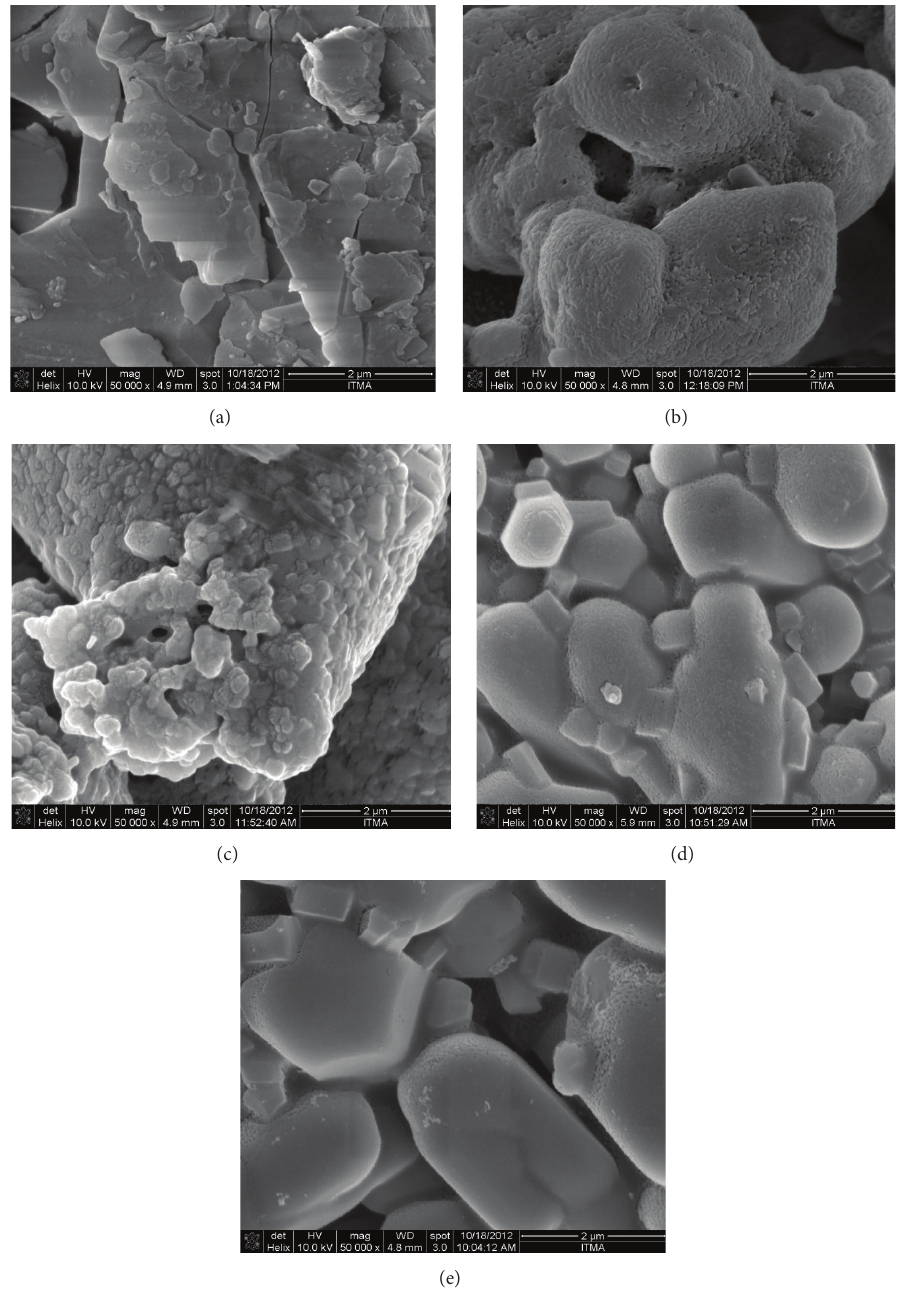
Figure 4: Microstructure of the sample treated at (a) 600 ∘ C, (b) 700 ∘ C, (c) 800 ∘ C, (d) 900 ∘ C, and (e) 1000 ∘